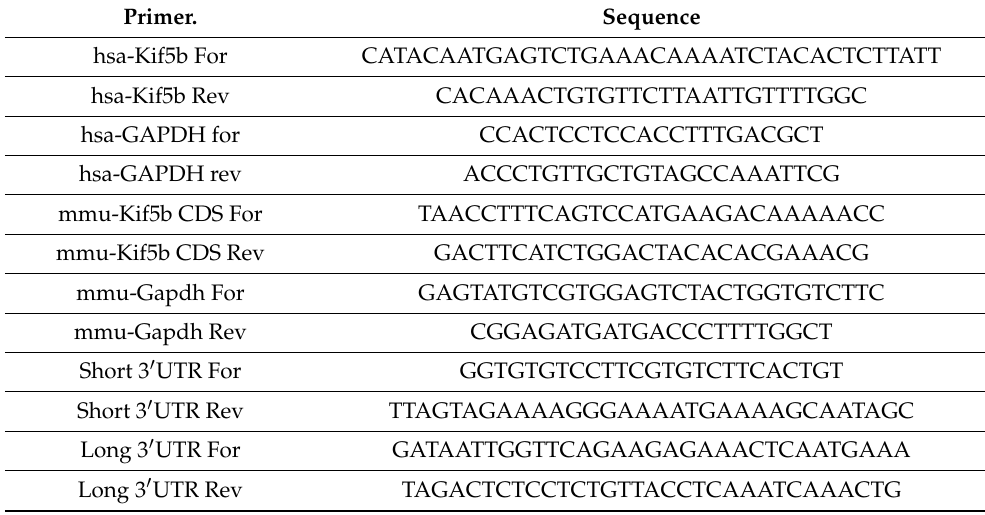
Table 2. SYBR green RT-PCR primers for mRNA quantification. Primer. Sequence